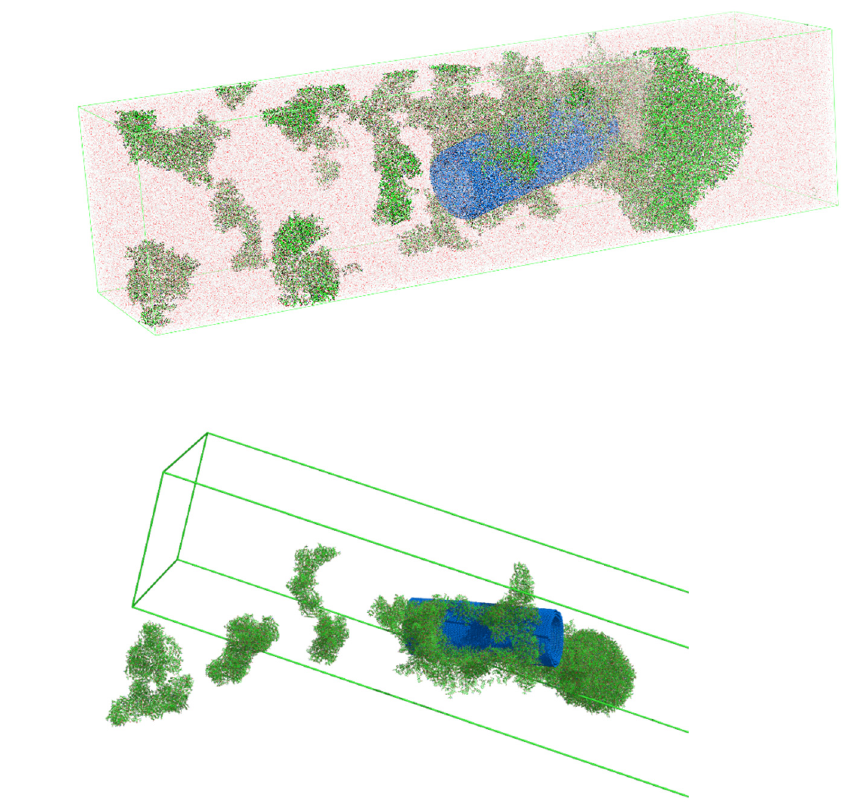
Figure 9. Molecular dynamics simulation snapshots of MWCNTs (marked in blue) system with doxorubicin (DOX, molecules indicated in green/dark red elements) and water (light red, high transparency for clarity) after time t = 35 ns from two perspectives: ( a ) view of the whole system in coordinates collapsed into the simulation box (periodic boundary); ( b ) view of the system in expanded coordinates, water molecules are not shown for transparency, four aggregates visible, three smaller DOX-only and one MWNTs + DOX.